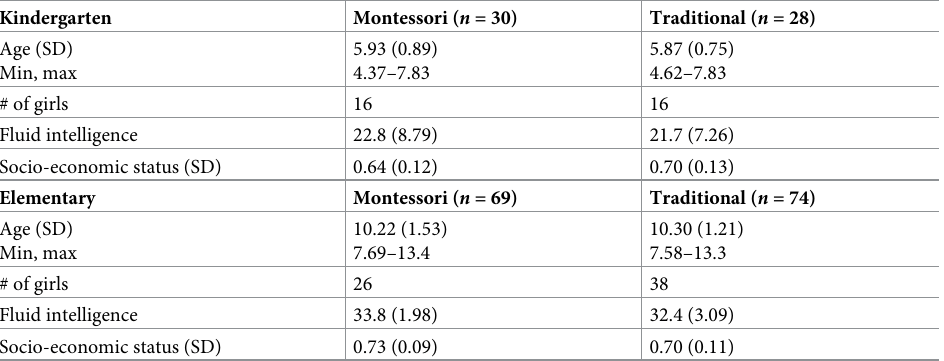
Table 2. Study participant